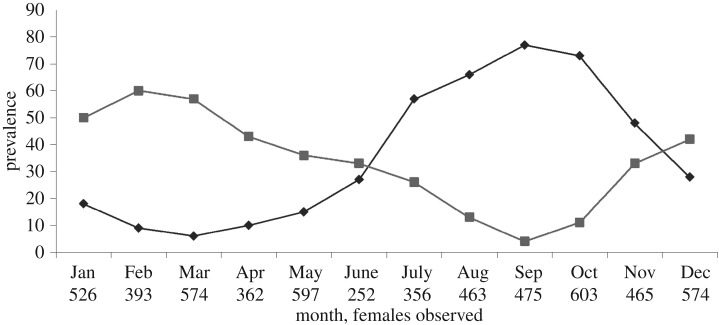
Reproductive seasonality. Prevalence (%) of adult females that were pregnant (diamonds) or lactating (squares). Numbers below month are sample sizes.